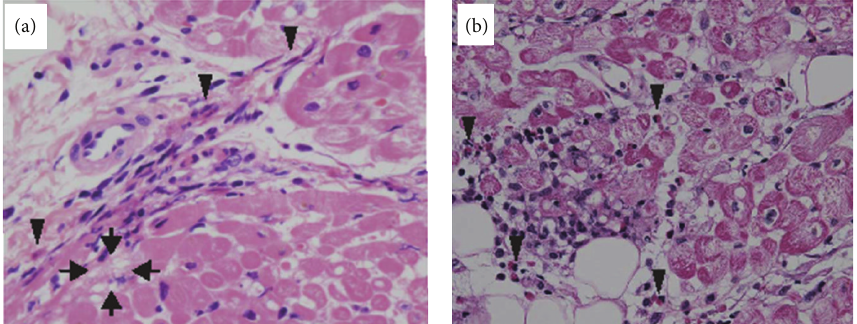
Figure 1: Endomyocardial biopsy of Case 1 (a) and Case 2 (b) (H-E staining; original magnification × 400). Focal and mild infiltration of eosinophil with degranulation (arrowhead) was seen in the interstitium of the myocardium. Some myocytes appeared degenerative (arrow).